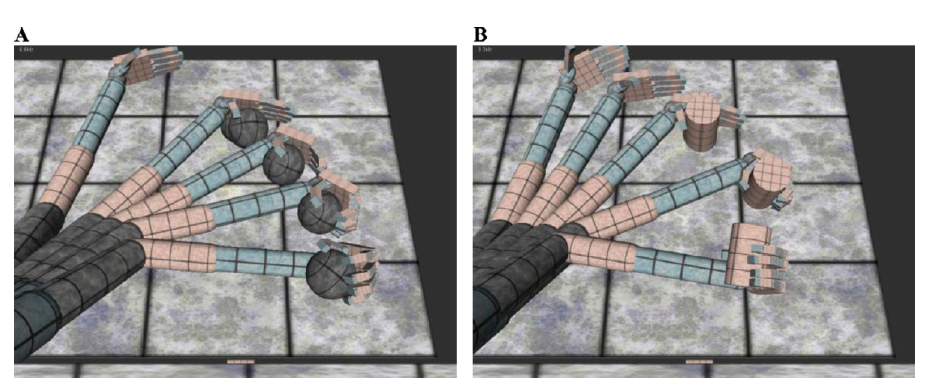
Figure 6. Five superimposed snapshots of the behaviour displayed by one of the best evolved robots . ( A ) The evolved robot grasping a sphere; ( B ) The same evolved robot grasping a cylinder.